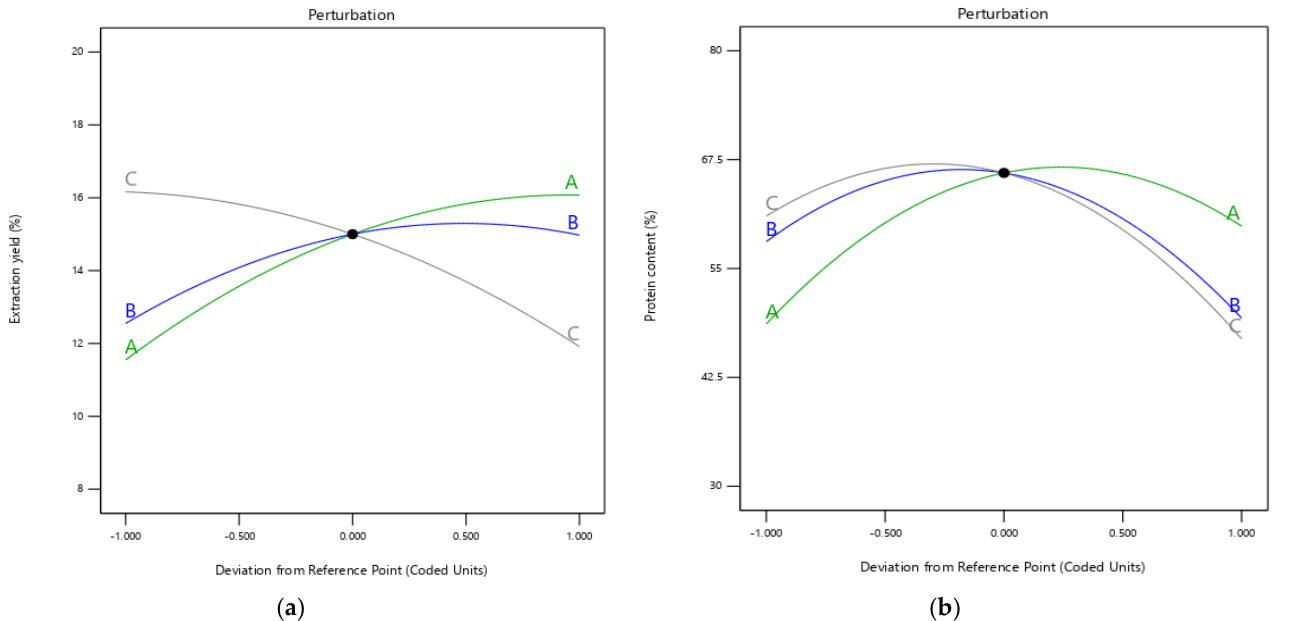
Figure 1. Perturbation plots representing the effect of extraction factors (A: pH; B: temperature; C: extraction time) on extraction yield ( a ) and protein content ( b ) of cherimoya-seed protein concen- trate.